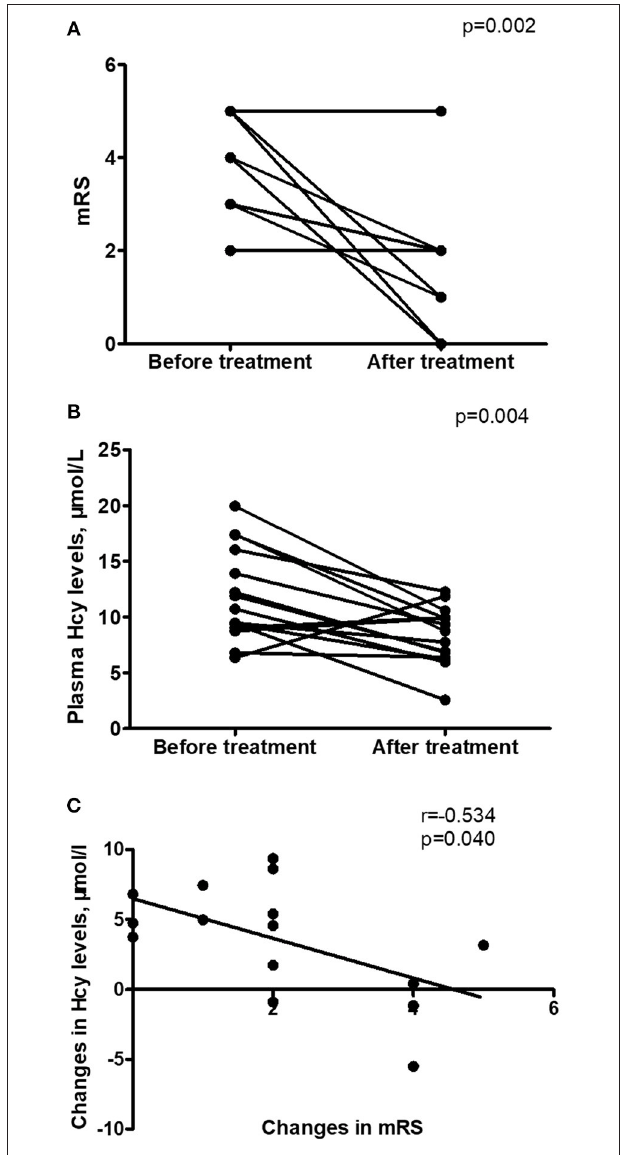
FIGURE 2 | Changes in homocysteine (Hcy) levels in anti-NMDAR encephalitis patients after treatment. (A) Improvement in modified Rankin Scale (mRS) scores from initial admission to 3-month follow-up after treatment. (B) Changes in Hcy levels from initial admission to 3-month follow-up after treatment. (C) Relationship between the changes in mRS scores and the changes in Hcy levels after treatment ( r = − 0.534, p = 0.040). n =